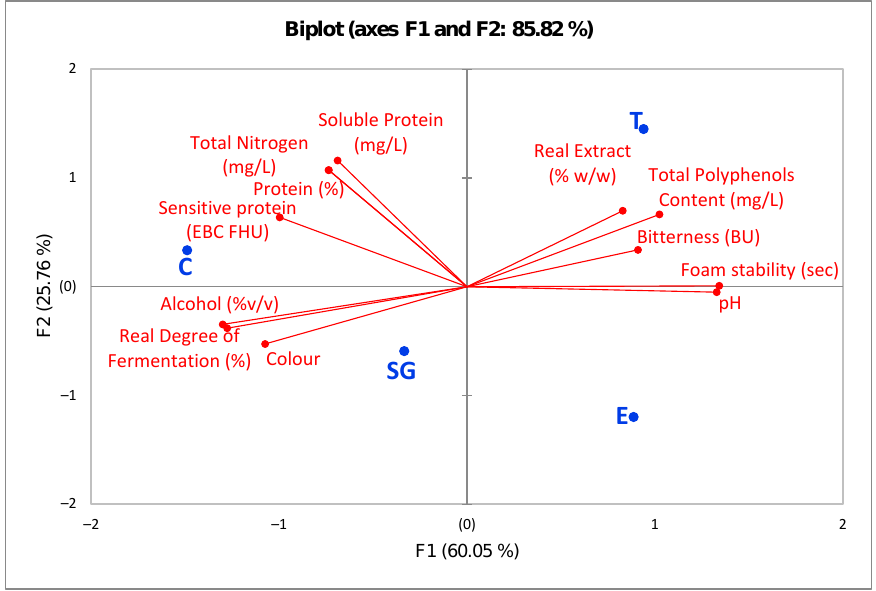
Figure 3. Principal component analysis of the physicochemical properties of the experimental beers. C = untreated sample; E = enzymatic-treated sample; T = tannins-treated sample; SG = silica gel- treated sample. Table 2. p -values of the two-sample test comparison, which tested for similarities between untreated sample (C) and beer subjected to a longer cold maturation (C30).